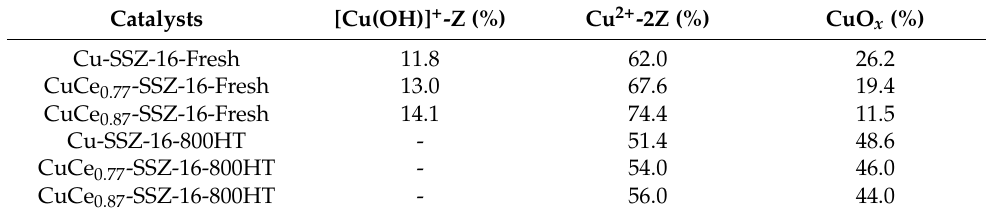
Table 4. The distribution of Cu species measured by H 2 -TPR.